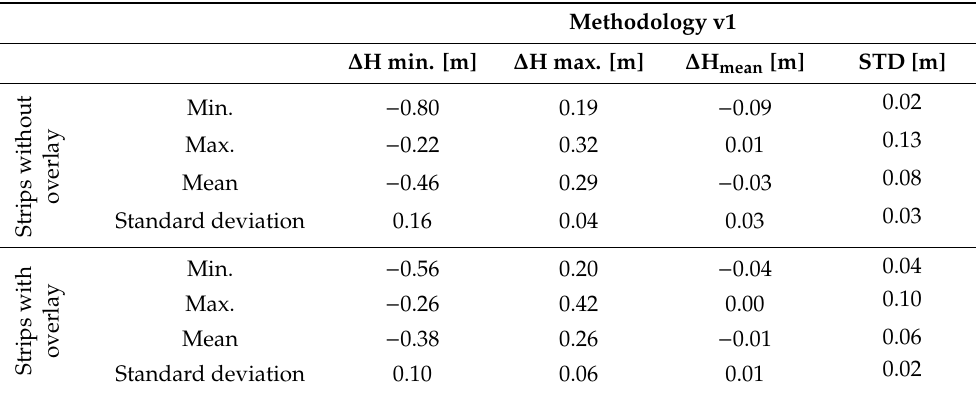
Table 8. Statistical characteristics for height di ff erences between strips (methodology v1). (Where: H—height, STD—standard